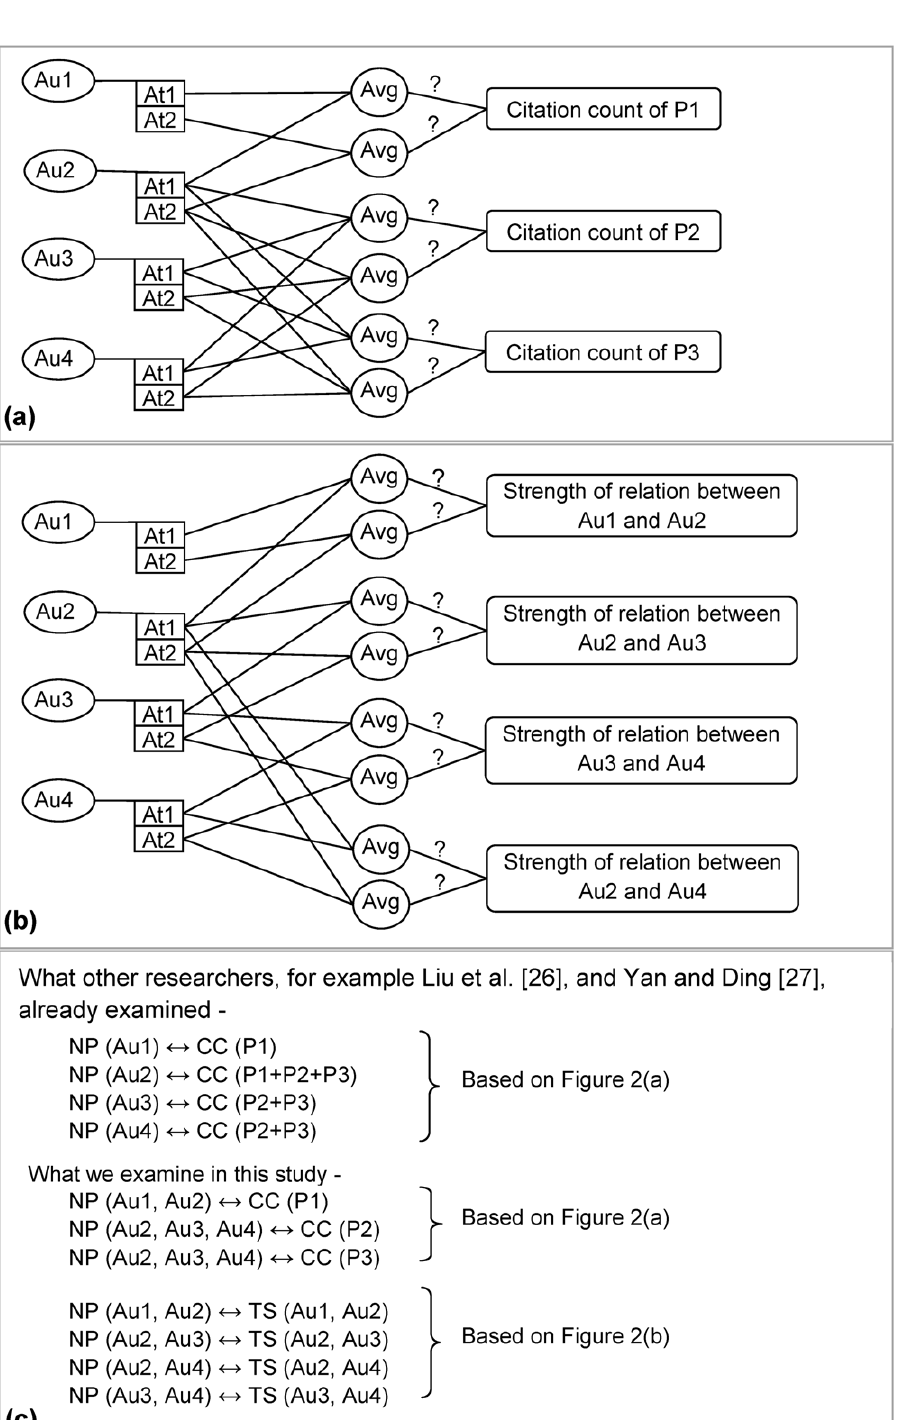
Figure 2. Conceptualization of the research questions of this study. (a) Illustration of the first research question (i.e., how the citation count of a scientific paper is affected by the network positions of its all co-author(s) in a co-authorship network?) based on Figure 1C. Avg stands for statistical function Average which is used to normalize different network attributes (i.e., degree centrality , closeness centrality and betweenness centrality ) of authors. The ‘‘?’’ symbol above the line indicates, whether or not, the measure on its left hand side has any impact on the measure on its right hand side. (b) Illustration of the second research question (i.e., how the strength of scientific relations (i.e., co-authorship relations) between two authors is affected by their network positions in a co-authorship network?) based on Figure 1C. Avg and ‘‘?’’ represent the same as like in (a). (c) Summary of research investigations. NP stands for Network Position in respect of network measures considered in this study (i.e., degree centrality , closeness centrality and betweenness centrality ), CC stands for Citation Count and TS stands for Tie strength . The symbol ‘ « ’ stands, whether the left hand measure of the symbol has any impact on its right hand measure.